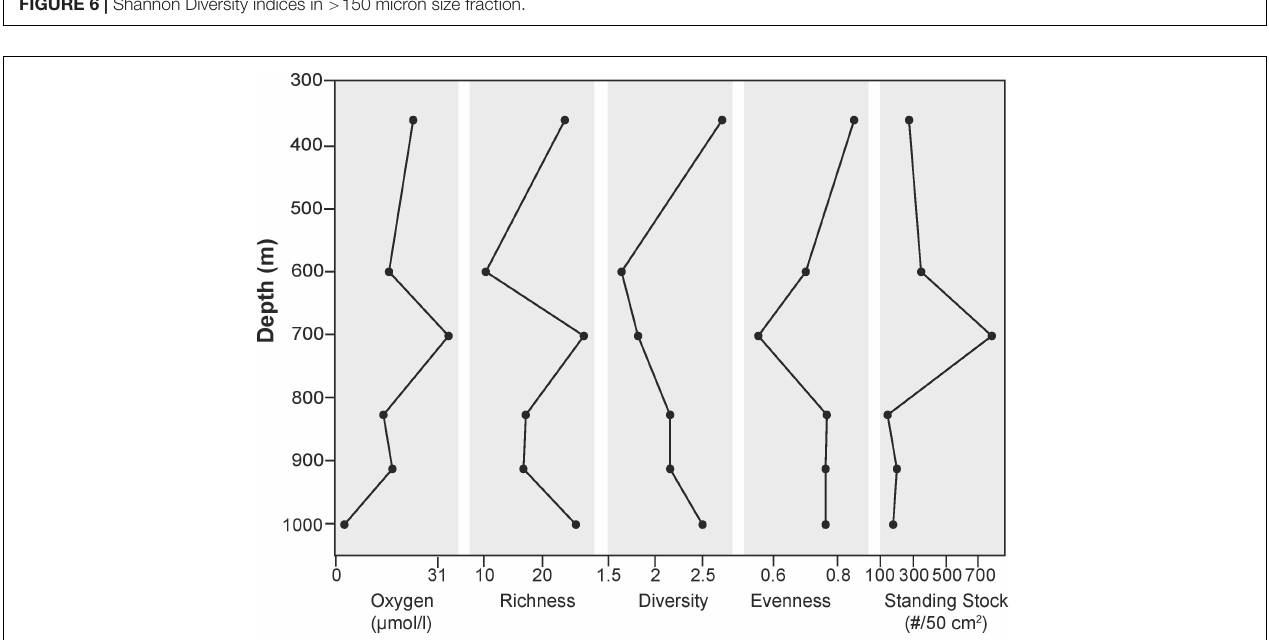
FIGURE 7 | Shannon Diversity indices in > 63 micron size